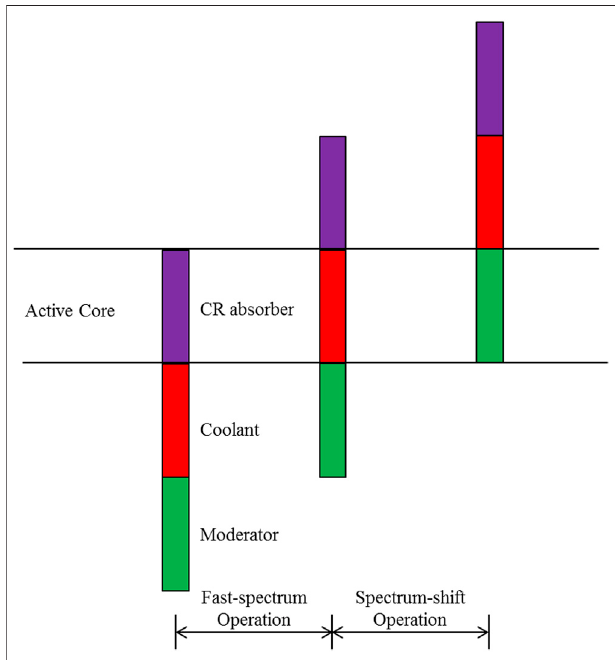
FIGURE 8 | Concept design of the control rod for the spectral-shift scheme.